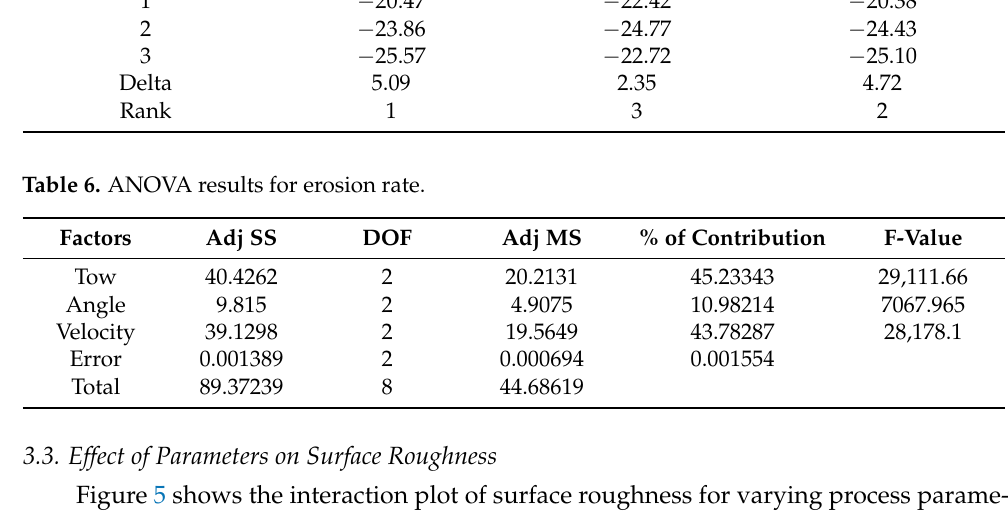
Table 6. ANOVA results for erosion rate.